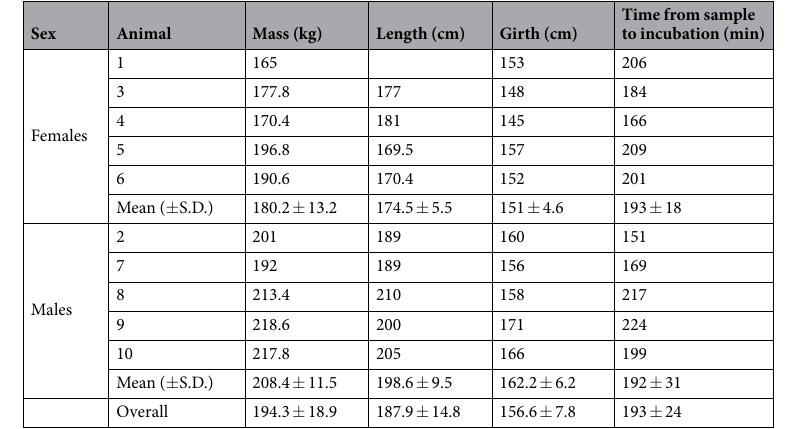
Table 1. Body mass, length and girth, sex and time elapsed between sampling and onset of incubation in media for wild adult grey seals sampled at Abertay Sands in August